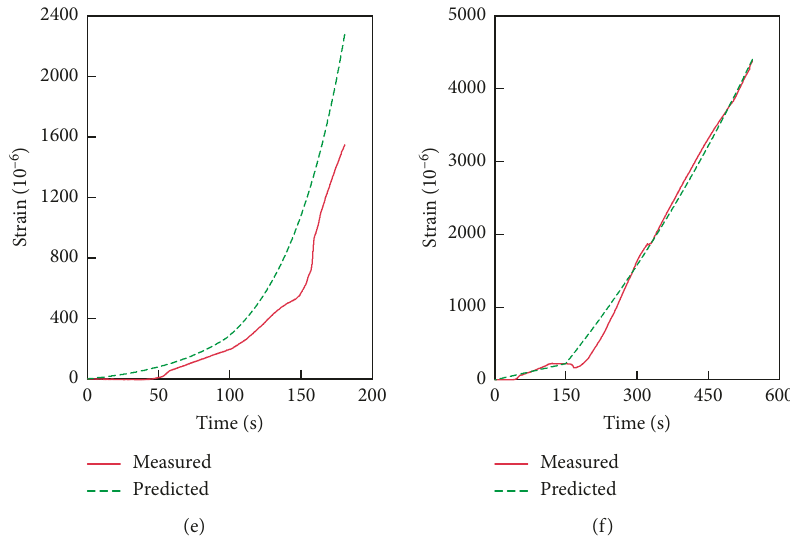
Figure 9: Prediction of each experimental stress and strain series. (a) Stress of Group 1. (b) Stress of Group 2. (c) Stress of Group 3. (d) Strain of Group 1. (e) Strain of Group 2. (f) Strain of Group 3.